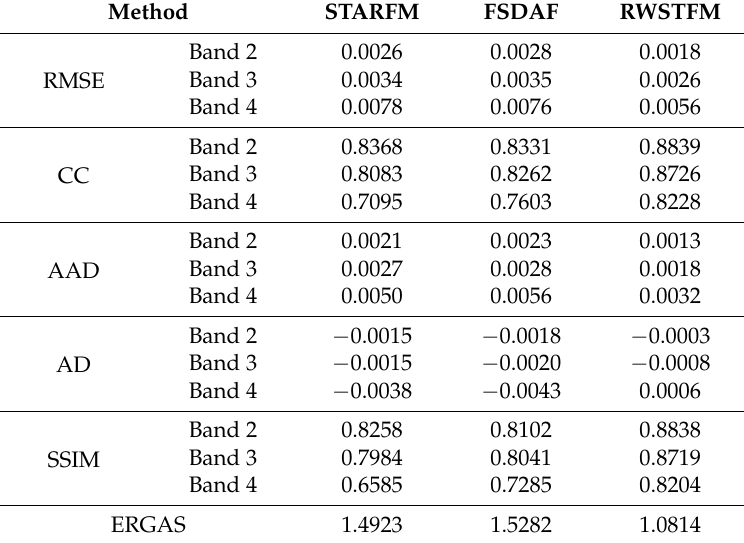
Table 1. The fusion results from the STARFM, FSDAF and RWSTFM methods evaluated using objective indices for the first dataset. CC, correlation coefficient; AAD, average absolute difference; AD, average difference; SSIM, structure similarity; ERGAS, erreur relative globale adimensionnelle de synthese.